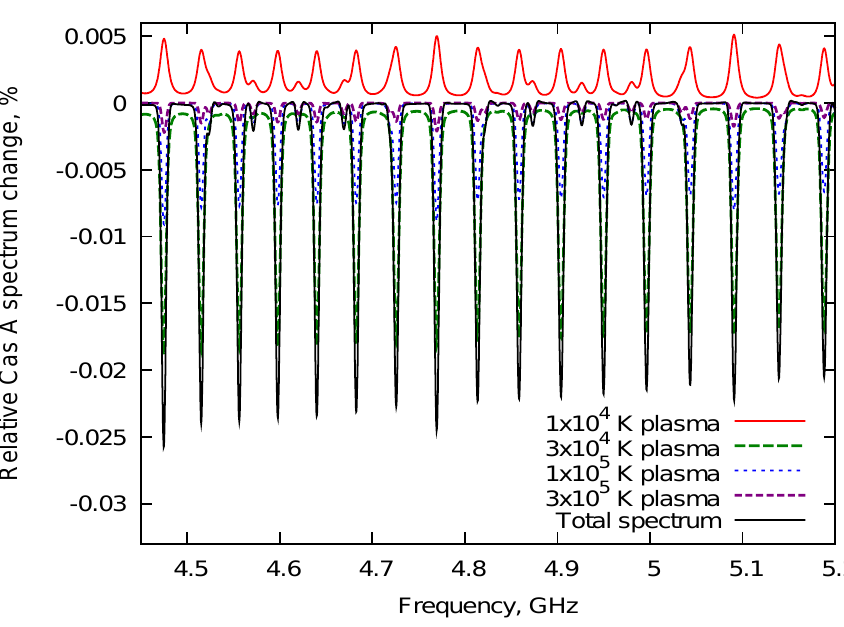
Fig. 3. Expected signature of the recombination lines in the radio spectrum of the fast-moving knots in the 6 cm radio